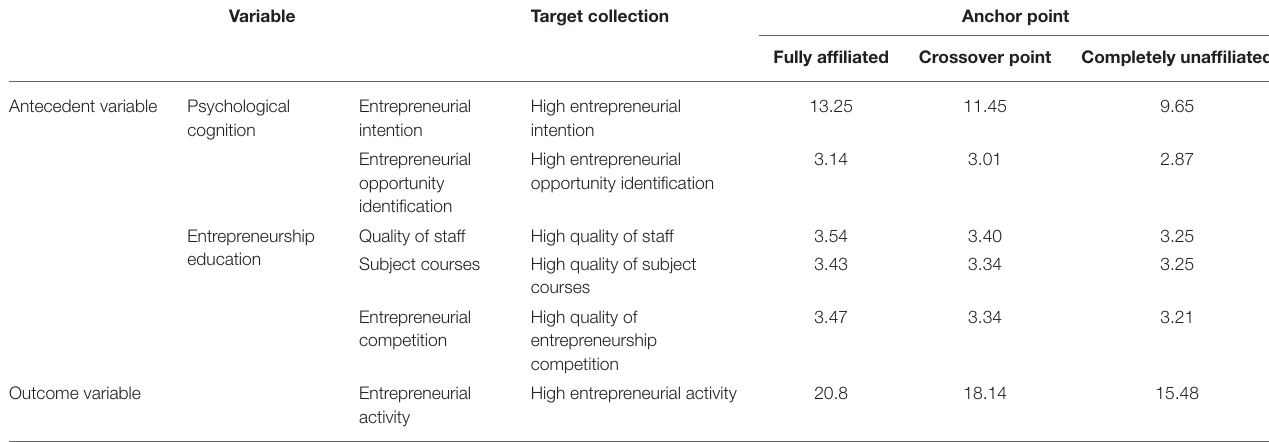
TABLE 3 | Calibration anchor points of various